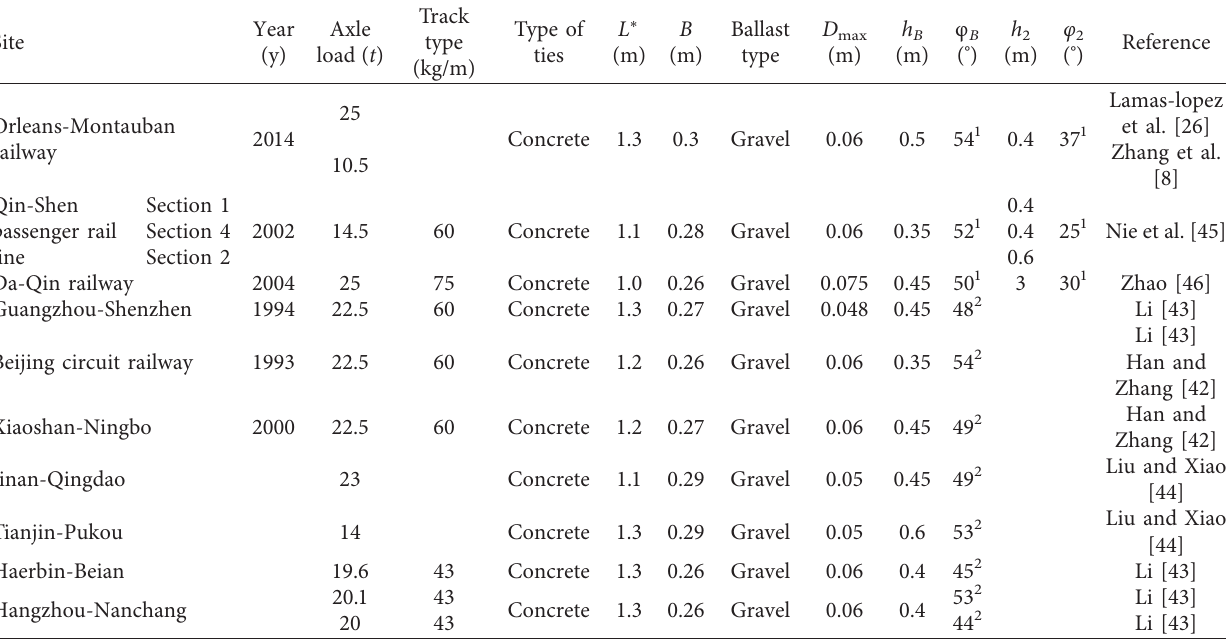
Figure 3: The average pressure distribution and actual pressure distribution at the tie-ballast Table 1: Database of railway geometric parameters in China and France.